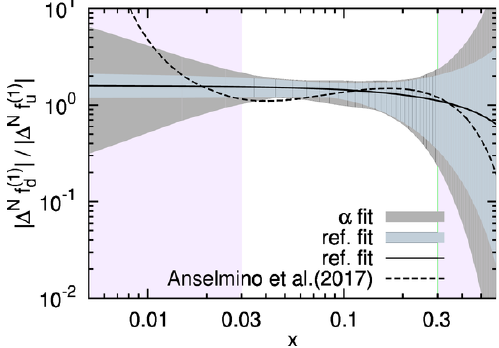
Figure 9 . Flavour ratio for the (cid:12)rst moments of the Sivers TMD distributions, j (cid:1) N f (1) j (cid:1) N f (1) j , as extracted in the reference (cid:12)t ( (cid:11) = 0) (light-blue bands) and in the (cid:11) -(cid:12)t (gray bands). u=p " The solid line shows the central line for the ratio, according to our reference (cid:12)t. For comparison, we include the corresponding central line according to the extraction of ref. [7]. The low- x and large- x regions, where experimental information is scarse, are highlighted in